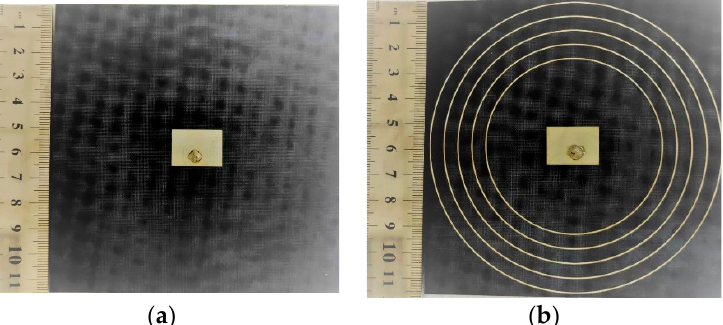
Figure 5. Fabricated antennas. The black part is the PTFE substrate with a permittivity of 3.5, the white part is the patch antenna and metamaterial units. The white spot in the center is the solder left by the welded SMA connector. ( a ) MPA; ( b ) MPA loaded with linear-type NPMMs. The gain of the two antennas is measured in the microwave anechoic chamber at 5.01 GHz. The radiation patterns of two antennas are shown in Figure 6b,c. The gain is changed from 7.47 to 9.58 dB with an increment of 2.12 dB.